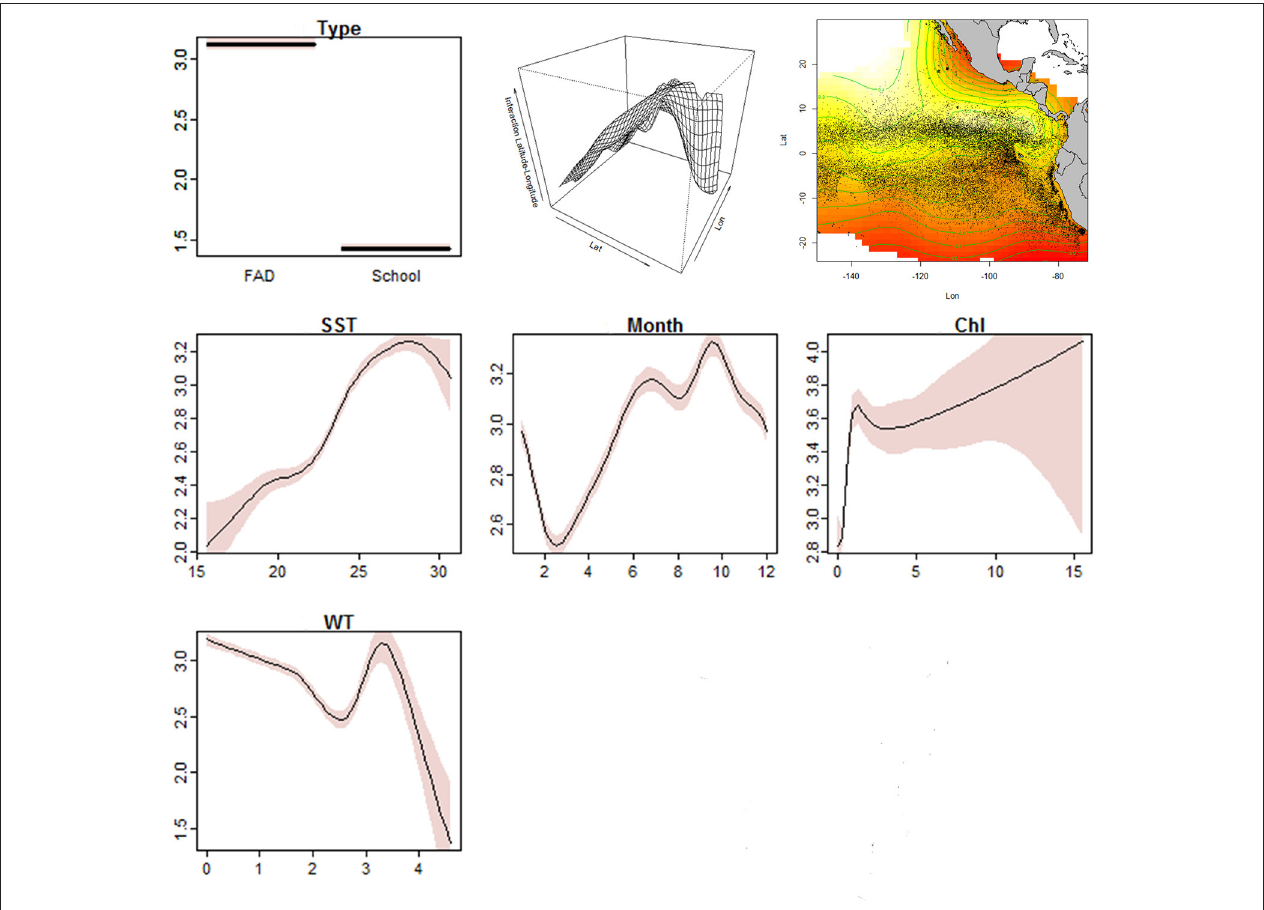
FIGURE 4 | Smoothed fits of covariates modeling the Species richness index of diversity for: Type (FAD vs. School), Interaction (Lat*Lon), SST (sea surface temperature, in ◦ C in x-axis), Month, Chl (chlorophyll, in mg m-3 in x-axis) and WT (total speed current, in knots in x-axis) variables. The y-axis represents the spline function. Dashed lines indicate approximate 95% confidence